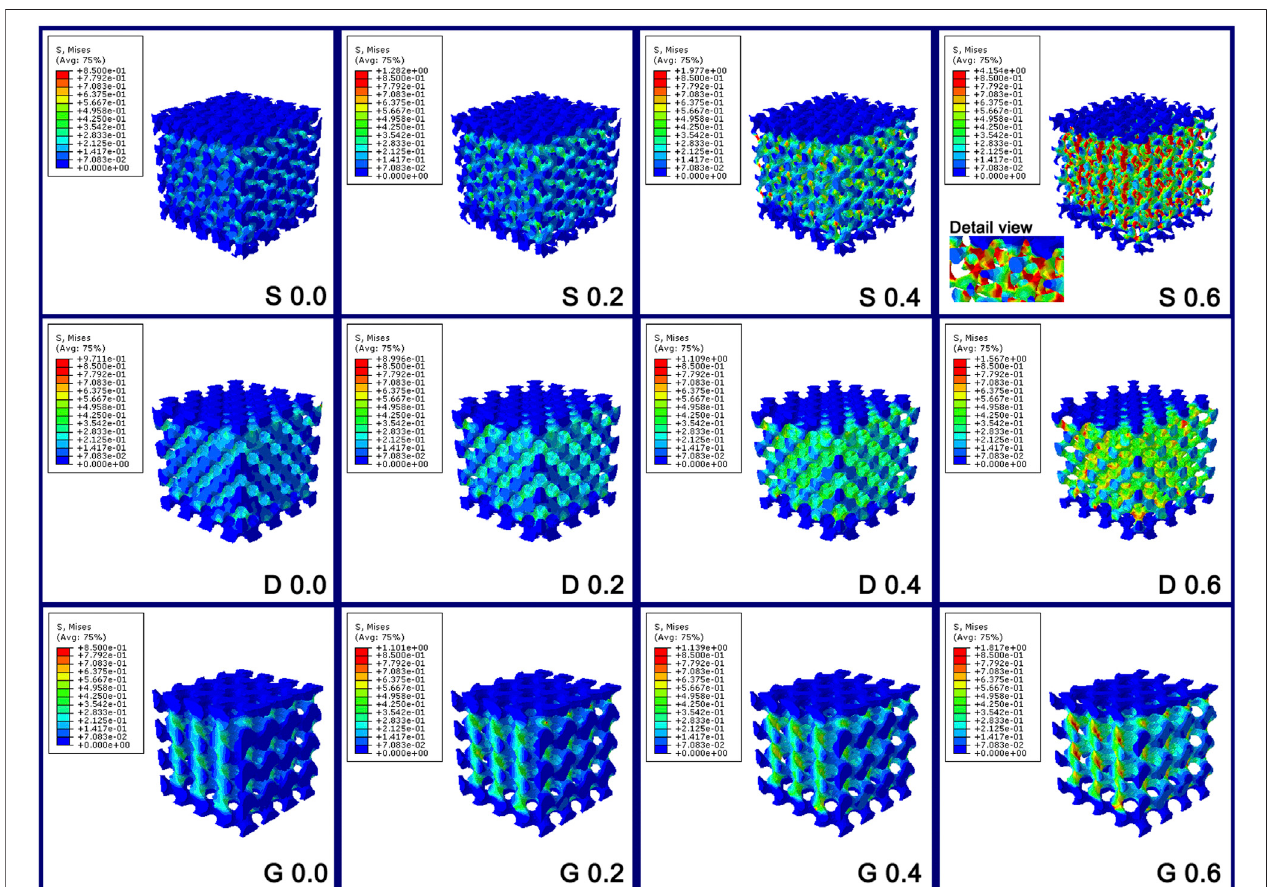
FIGURE 6 | The stress distribution diagram of the porous scaffolds through the fi nite element analysis. The stress variation tendency in S porous scaffolds was steep; however, that of D and G porous scaffolds were